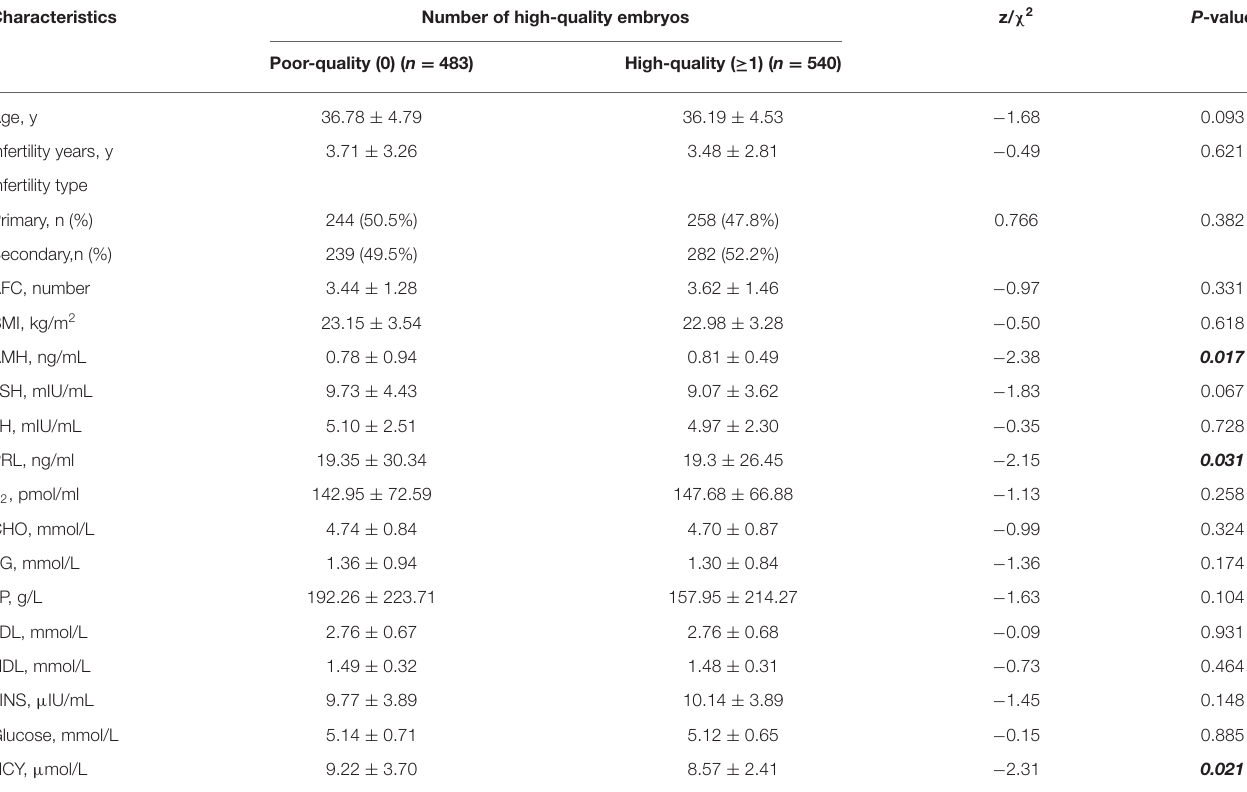
TABLE 1 | Characteristics of the patients with DOR.